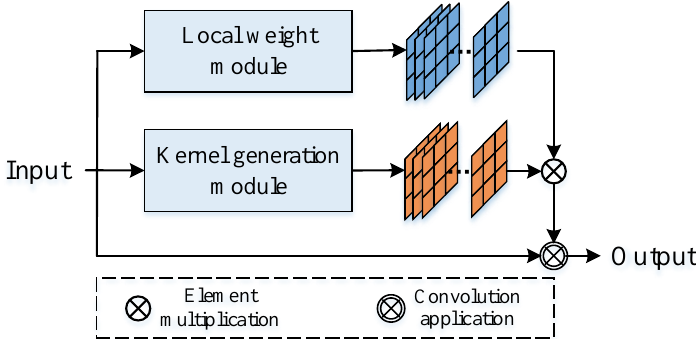
Figure 4. Filter Convolutional Layer